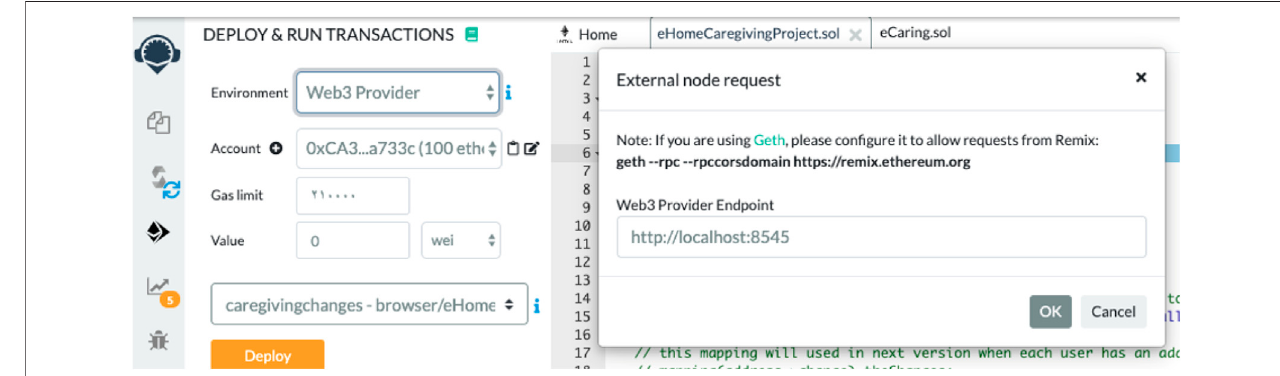
FIGURE 12 | Screen shot of Web3 provider as execution